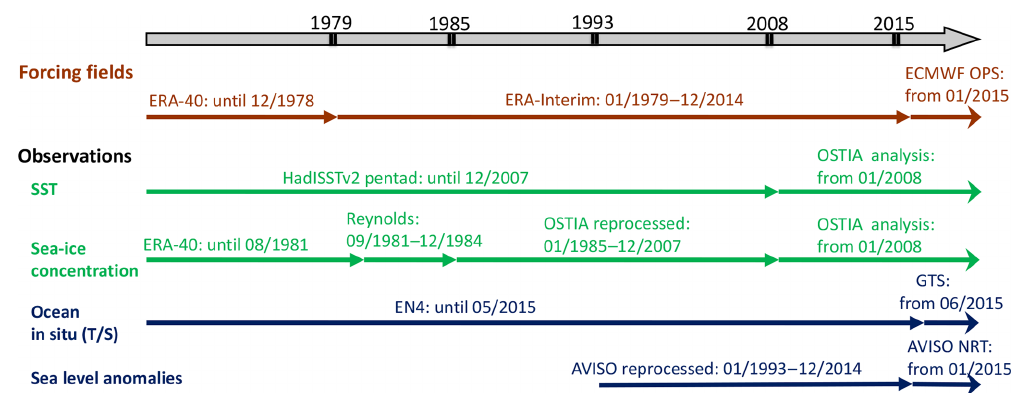
Figure 3. Time line of changes to the reanalysis forcing and assimilation data sets for